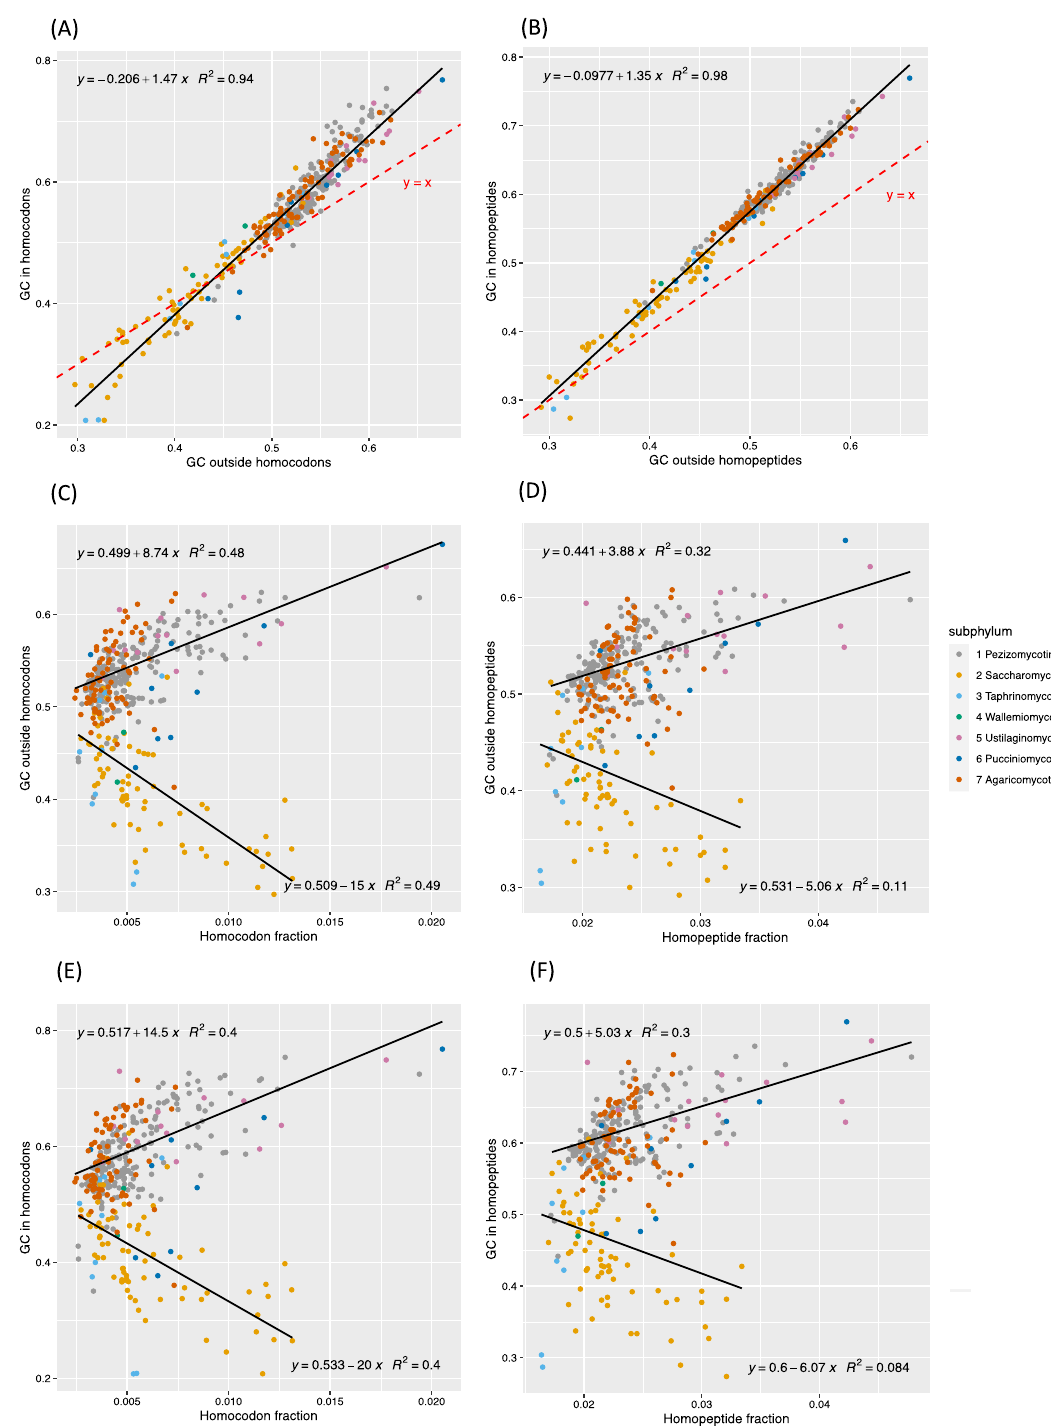
Figure 3. Relationship between homopeptide/homocodon level and GC/AT level. ( a ) GC/AT level in homocodons versus outside homocodons in coding regions. The red dashed line shows the default where GC/AT levels outside and inside homocodons are identical ( y = x line). ( b ) GC/AT level in homopeptides versus outside homopeptides. The y = x line is shown (red dashed line). ( c ) GC/AT-level outside homocodons versus the fraction of homocodons, with separate linear regressions for GC-biased and AT-biased organisms. That is, they are separated into two groups one with GC fraction ≥ 0.5, and one with GC fraction < 0.5. ( d ) GC/AT-level outside homopeptides versus the fraction of homopeptides, with separate linear regressions for GC-biased and AT-biased organisms, as in part ( c ). ( e ) GC/ AT-level in homocodons plotted versus the fraction of homocodons, with separate linear regressions for GC-biased and AT-biased organisms, as in part (c). ( f ) GC/AT-level in homopeptides plotted versus the fraction of homopeptides, with separate linear regressions for GC-biased and AT-biased organisms, as in part ( c ). All correlations in parts ( a )–( f ) are significant at P < 0.05. A legend explaining the colour-coding for each subphylum is at the right of the